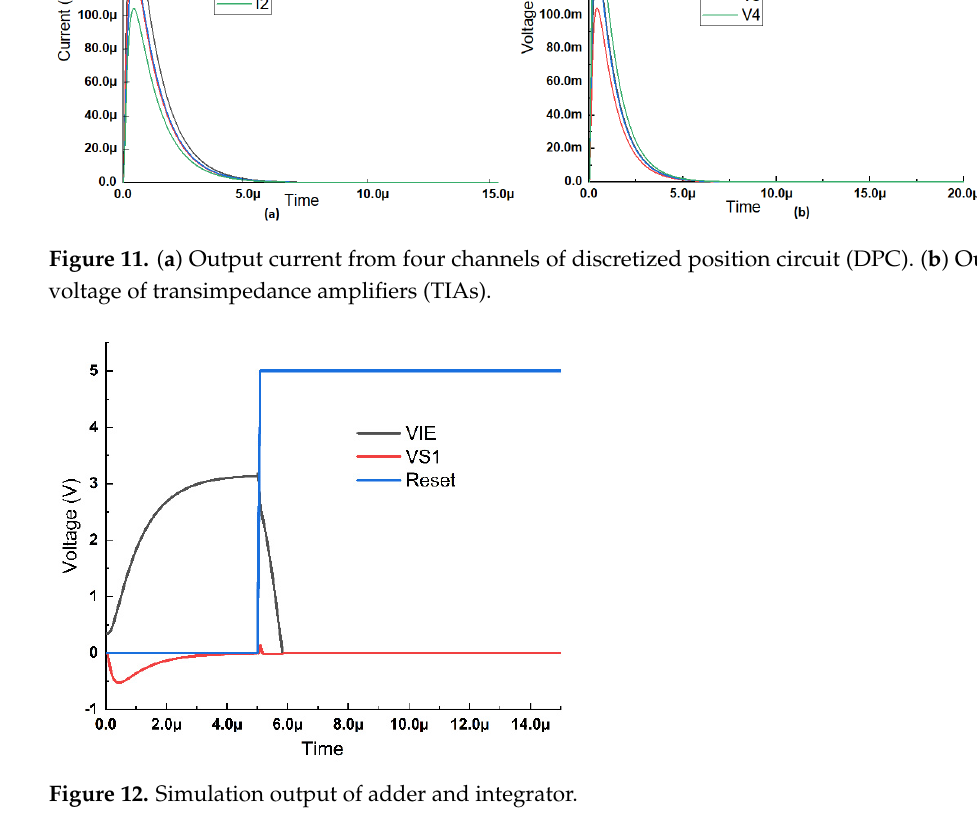
Figure 12. Simulation output of adder and integrator.